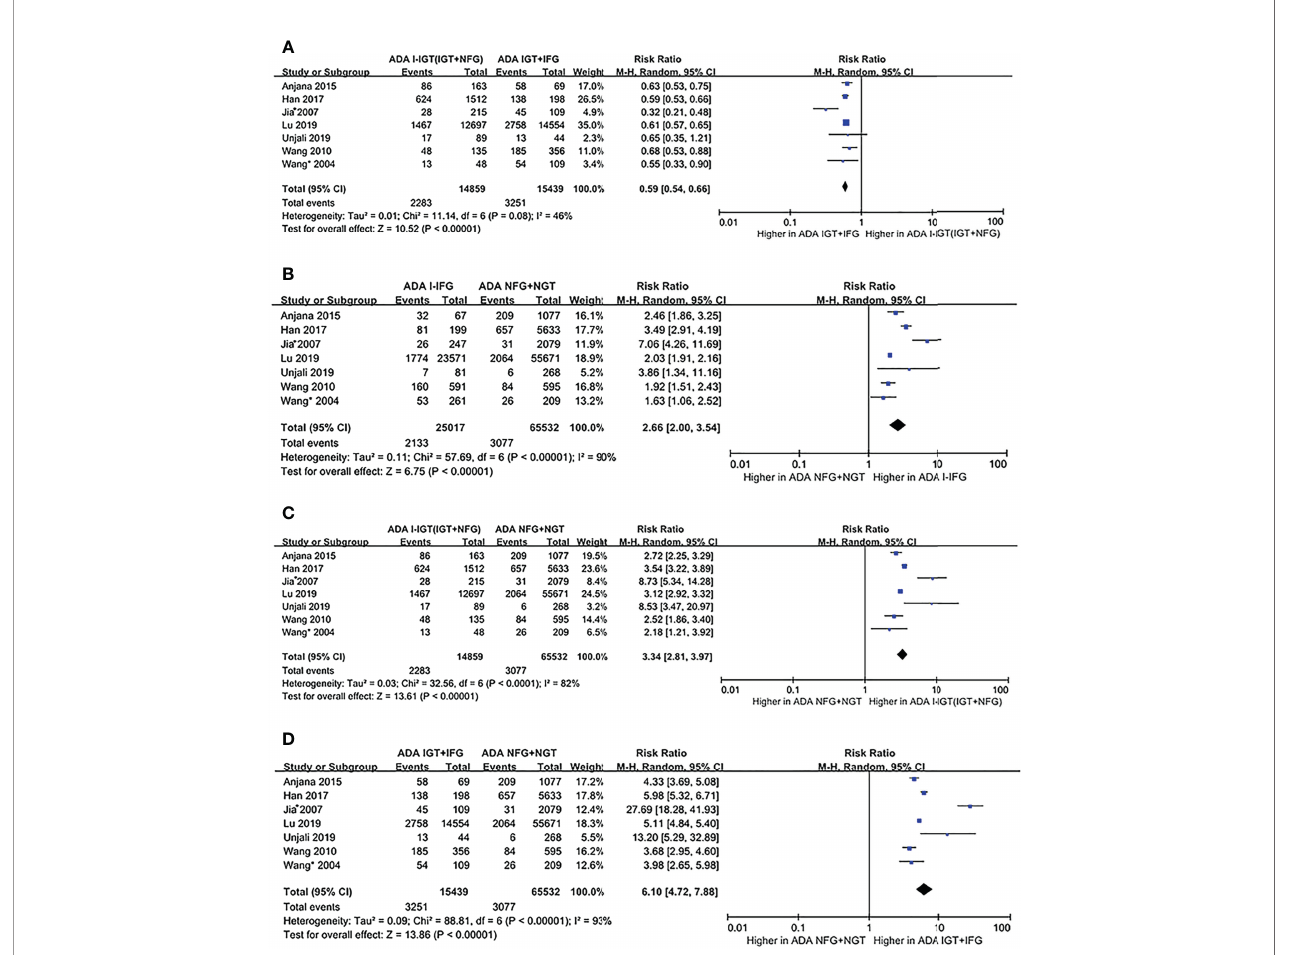
FIGURE 3 | Forest plots comparing the risk of progression to type 2 diabetes between groups according to the ADA 2003 classi fi cation criteria. (A) The risk of progression to type 2 diabetes was higher in the ADA IGT+IFG group than in the ADA I-IGT (IGT+NFG) group. (B) The risk of progression to type 2 diabetes was higher in the ADA I-IFG group than in the ADA NFG+NGT group. (C) The risk of progression to type 2 diabetes was higher in the ADA I-IGT (IGT+NFG) group than in the ADA NFG+NGT group. (D) The risk of progression to type 2 diabetes was higher in the ADA IGT+IFG groups than in the ADA NFG+NGT group. 95% CI, 95% con fi dence interval; I-IGT, isolated impaired glucose tolerance; IGT+IFG, impaired fasting glucose combined with impaired glucose tolerance; I-IFG, isolated impaired fasting glucose; NFG+NGT, normal fasting glucose combined with normal glucose